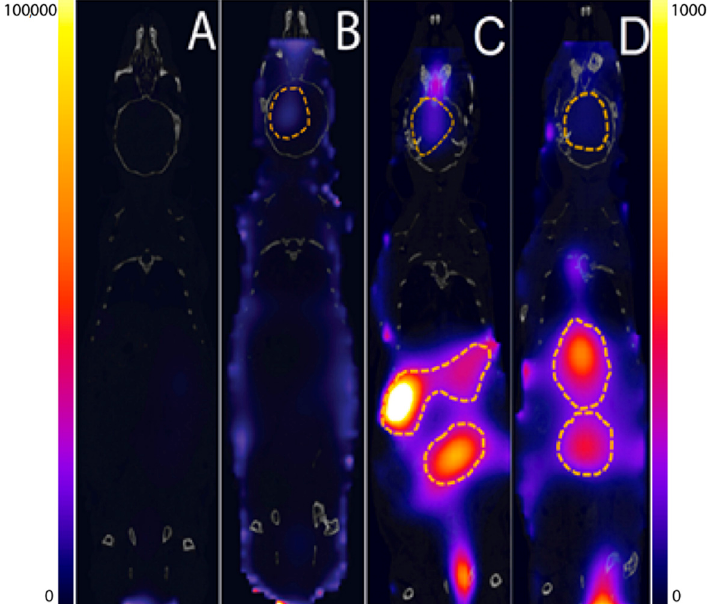
Figure 4. The whole body FLECT (Fluorescence Emission Computed Tomography)/CT (Computed Tomography) images of PFT-Hcy-HSA-Cy7-pTFT ( A , B ) and alb-TFT-AuNP ( C , D ) distribution at different time points in mice with severe combined immunodeficiency (SCID) with the brain tumor caused by the intracranial injection of a human glioblastoma cell line U87. Images were taken under the same conditions at 1 h ( A , C ) and 72 h ( B , D ) postinjection. Albumin conjugate PFT-Hcy-HSA-Cy7-pTFT accumulates in the malignant tissue (dotted line) of mouse brain 72 h after their intravenous injection ( B ). alb-TFT-AuNP conjugate predominantly localizes in liver ( C , D ). For a better visual display of the fluorescent label distribution in animals A , B and C , D , different boundary conditions of the signal intensity scale were chosen.